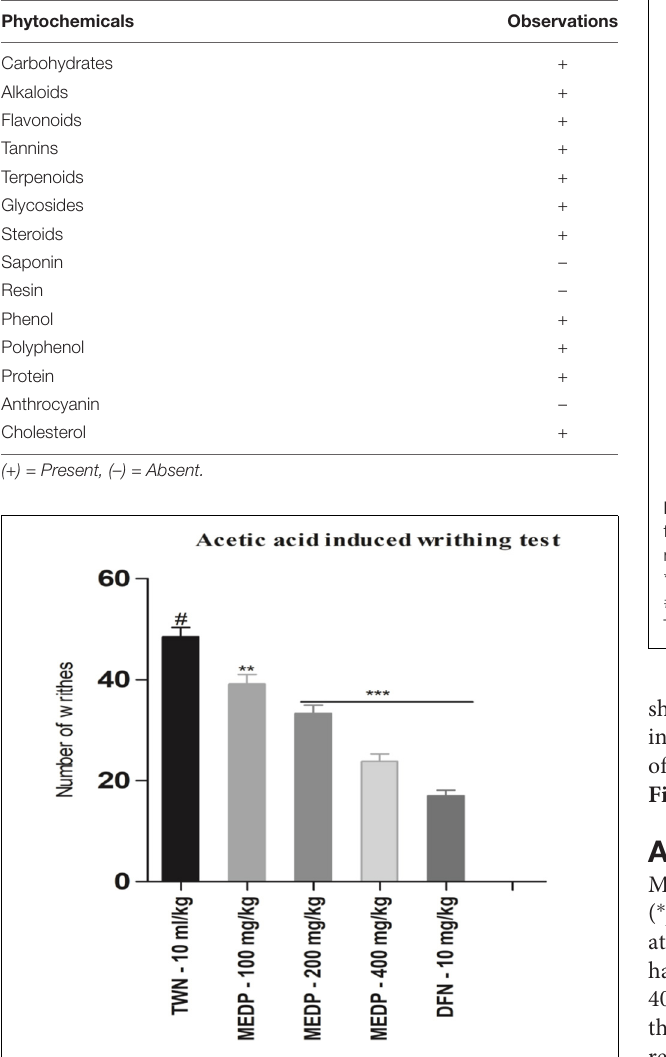
FIGURE 1 | Effects of various test doses of MELM on the acetic acid-induced writhing test in mice ( n = 6). Values are presented as mean ± SEM; one-way ANOVA followed by Dunnett’s test. * p < 0.05, ** p < 0.01, and *** p < 0.001 were considered as significant compared with the control, where # is